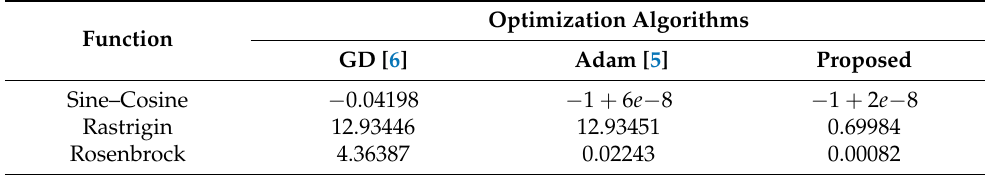
Table 1. Minimum values achieved by various algorithms.